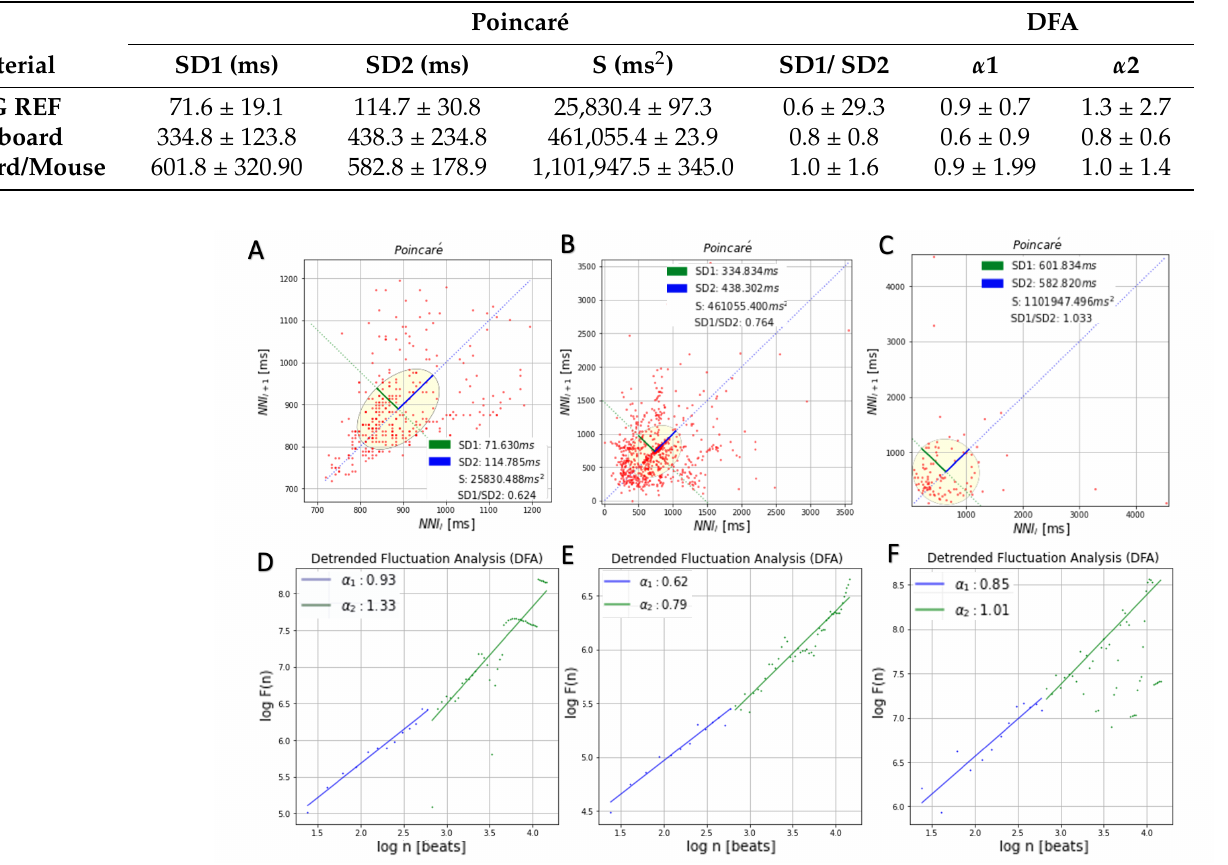
Figure 4. Poincaré and DFA plots for ECG REF ( A , D ) and ECG EXP with keyboard ( B , E ) and keyboard/mouse ( C , F